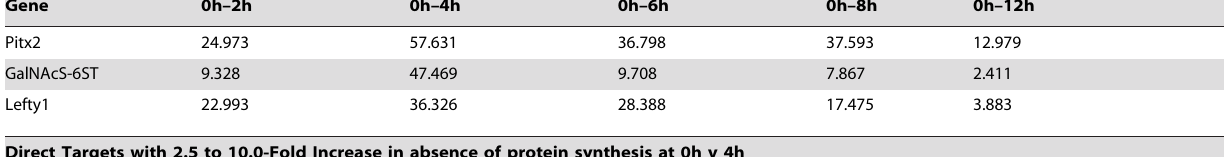
Table 3. Behaviour and classification of 34 target genes in the absence of protein synthesis